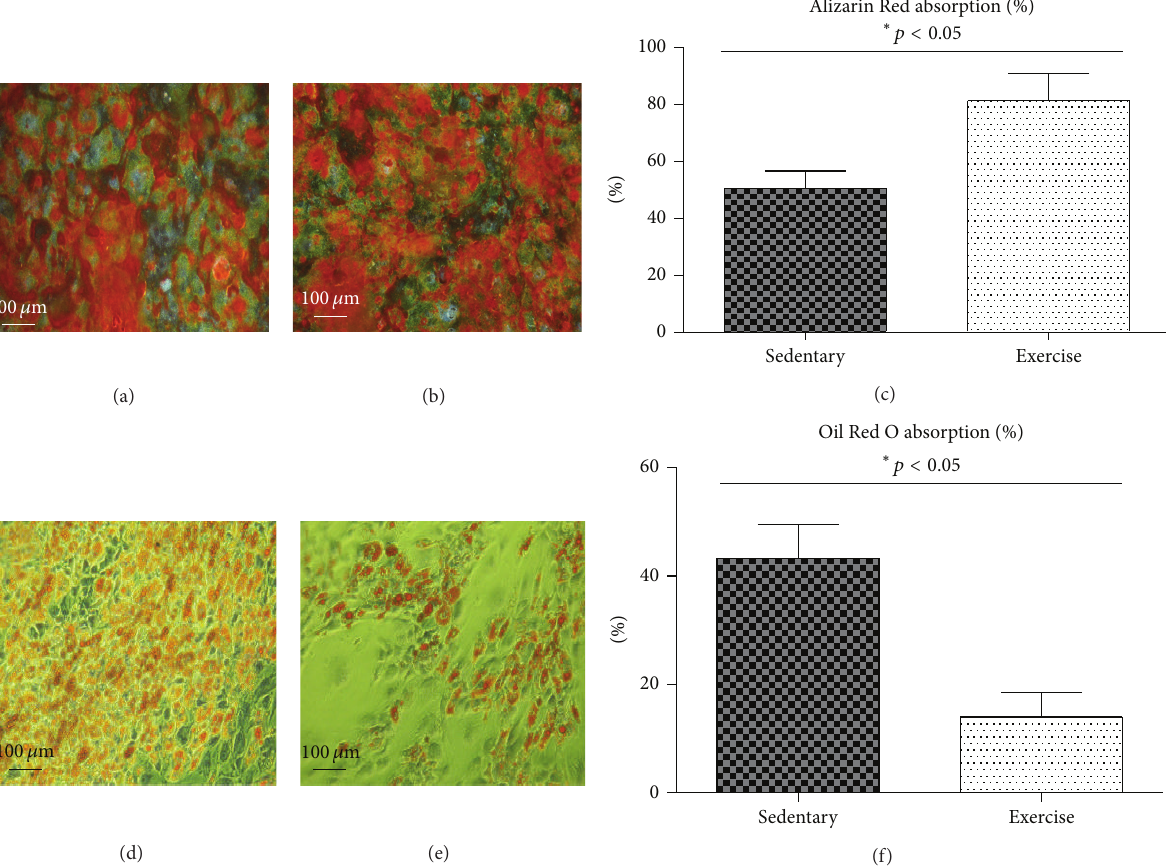
Figure 6: Alizarin Red staining of osteoblasts derived from MSCs collected from sedentary (a) and exercised (b) individuals and quantity of absorbed dye (c).(d, e, and f) Representative images of 21d, Oil Red O stained and quantified, and differentiated MSCs isolated from sedentary (d) and exercise-trained (e) animals. Percentage of Oil Red O absorption (f) cells derived from sedentary and exercised animals. Statistical significance ( 𝑝 < 0.05